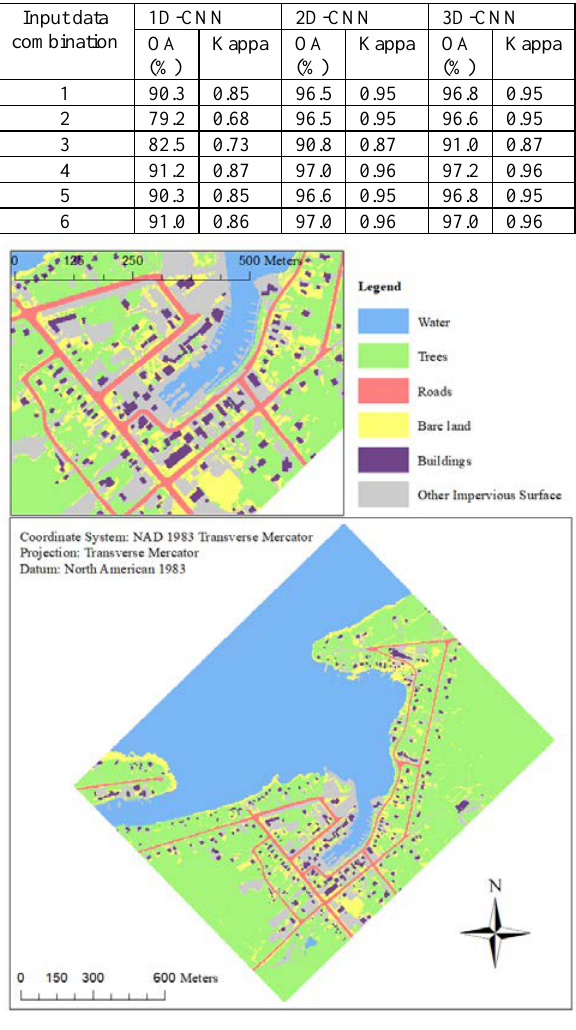
Figure 7. Labelled LC map of the study